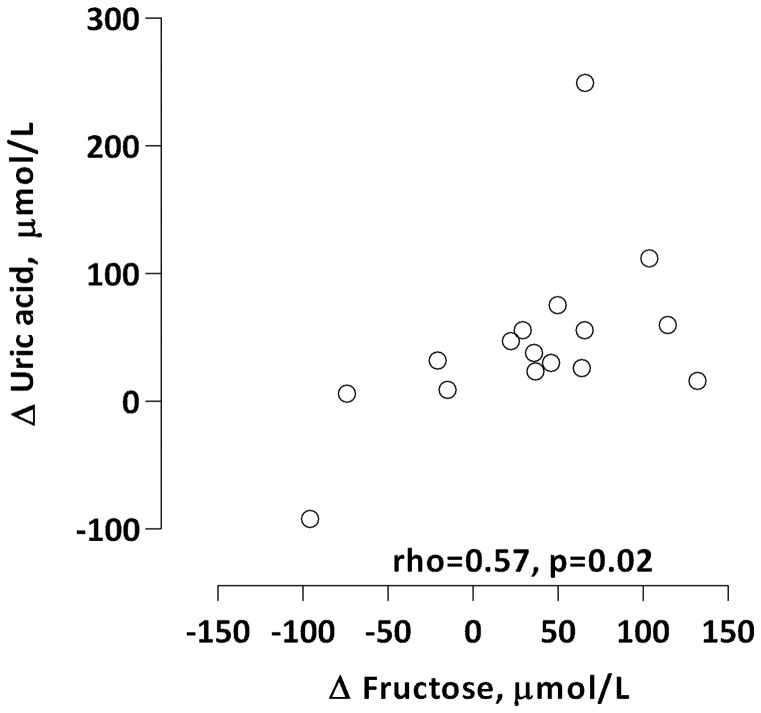
A positive correlation was observed between changes (Δ) in fructose and uric acid from winter to summer.This suggest that higher uric acid levels observed during the active summer period is in part dependent on increased fructose intake via fruits and berries.